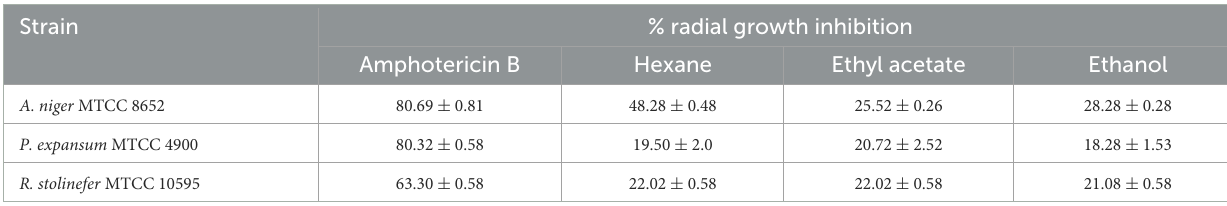
TABLE 1 Inhibitory activity of M. purpureus pigment extracts on the radial growth of fungi on the PDA medium. Strain